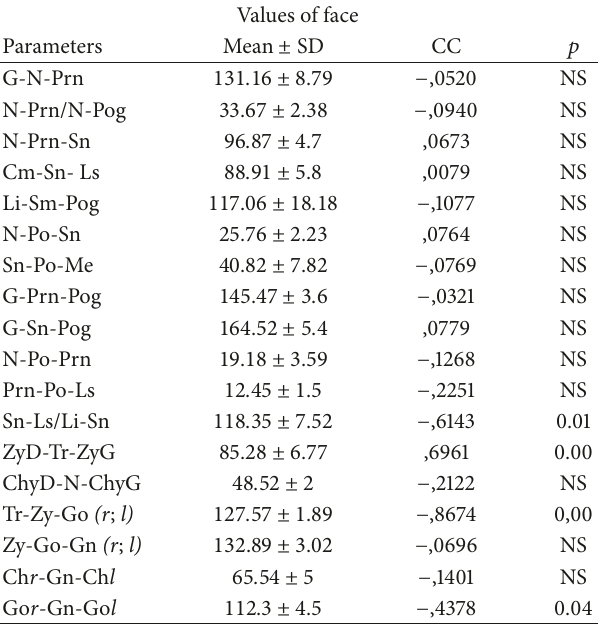
Table 6: Correlation between indices values and angles measure- ments of the face.